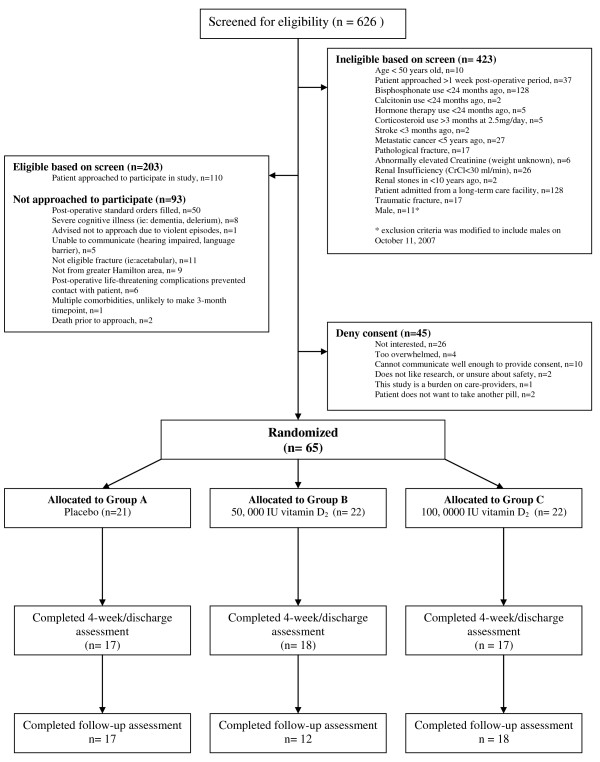
Patients Screened.